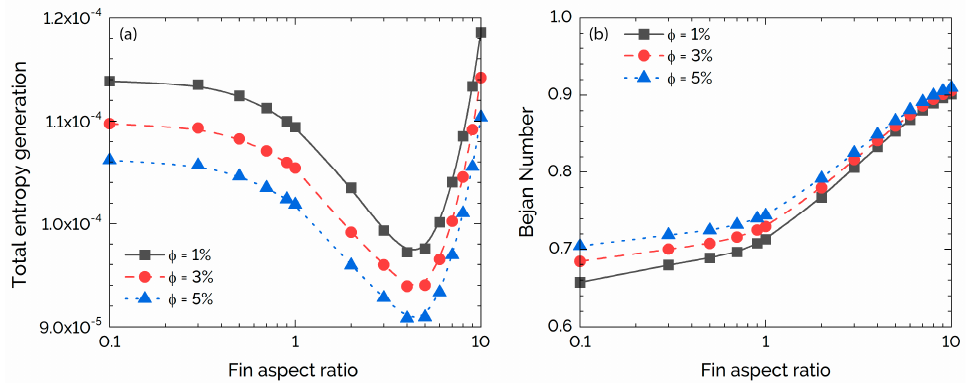
Figure 10. Effects of fin aspect ratio and nanoparticle concentration ( ϕ ) on entropy generation for CuO-water nanofluid: ( a ) total entropy generation and ( b ) average Bejan number.